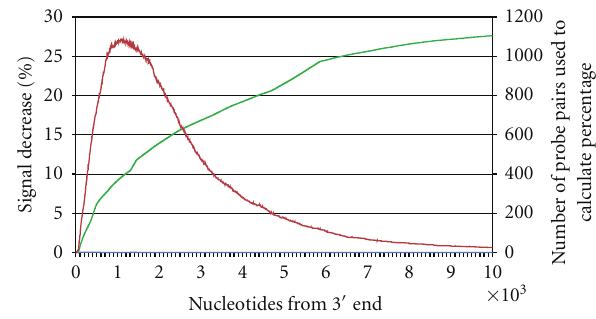
Figure 6: Correlation between log-intensities (green curve) from multiple target oligonucleotides predicted to lie within the same gene according to distance of the target from the 3 (cid:2) transcript end. The red line shows the number of probe pairs used to estimate the signal drop.